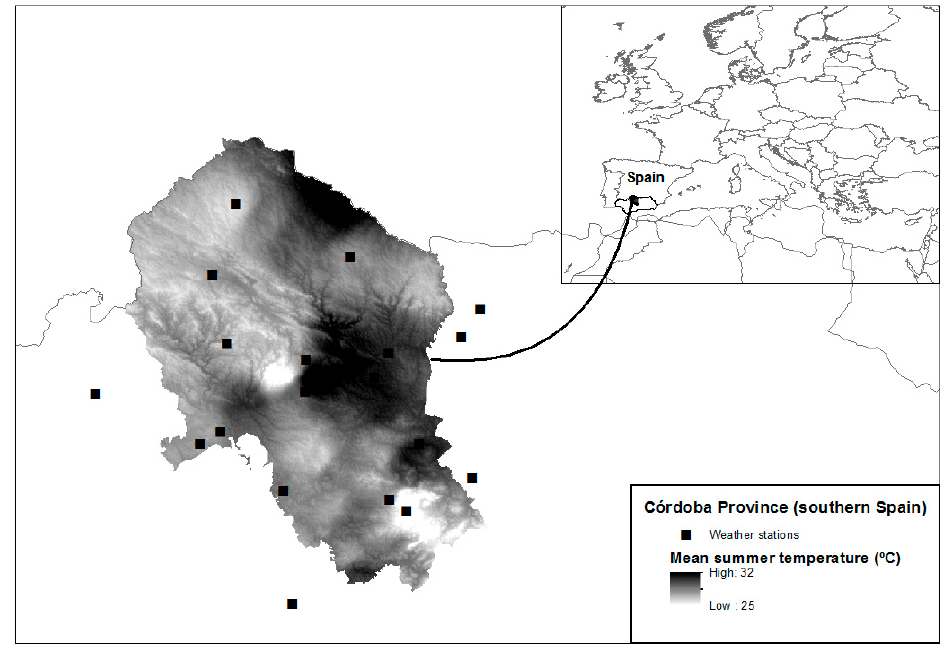
Figure 1. Study area location with selected weather stations.